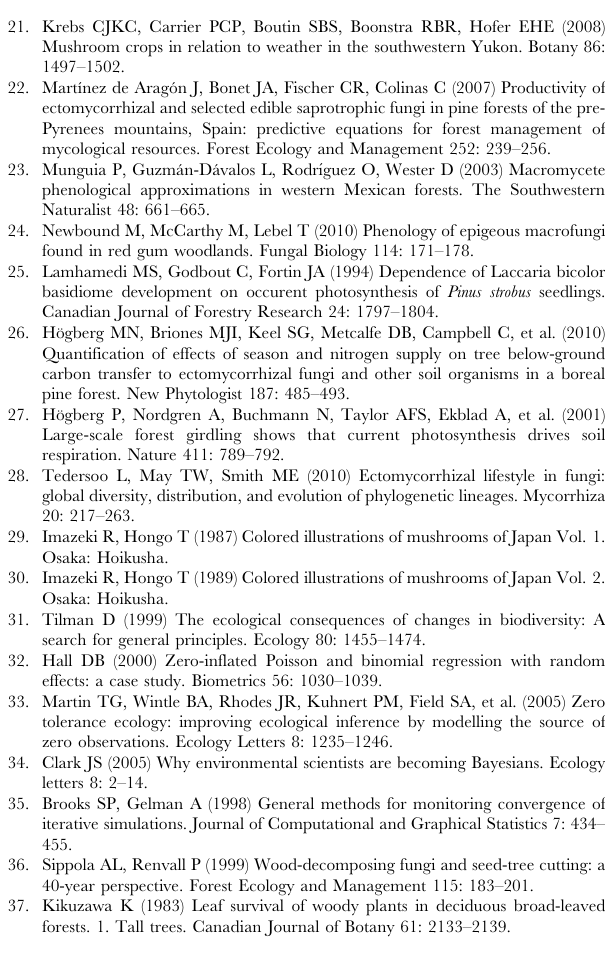
Figure S1 Locality and aerial photography of the study site. The white arrow represents the trail followed during the surveys. Figure S2 Monthly change in the number of fruiting species for wood-decomposing fungi that form ephemeral fruiting bodies (a) and long-lived fruiting bodies (b). Different letters indicate results that differ significantly at P , 0.05 (SteelDwass test). Figure S3 Density plot for posterior distribution of standard partial regression coefficients when the num- ber of fruiting species in ectomycorrhizal (ECM) fungi, litter-decomposing fungi, and wood-decomposing fungi was regressed against monthly temperature (T), month- ly accumulated rainfall (MR), weekly accumulated rainfall (WR), and elapsed years (Y). A positive regression coefficient value indicates that the corresponding variable is positively correlated with the number of fruiting species, whereas a negative value indicates the reverse. Single asterisks indicate that 95% credible intervals do not include zero, and double asterisks indicate 99% credible intervals.